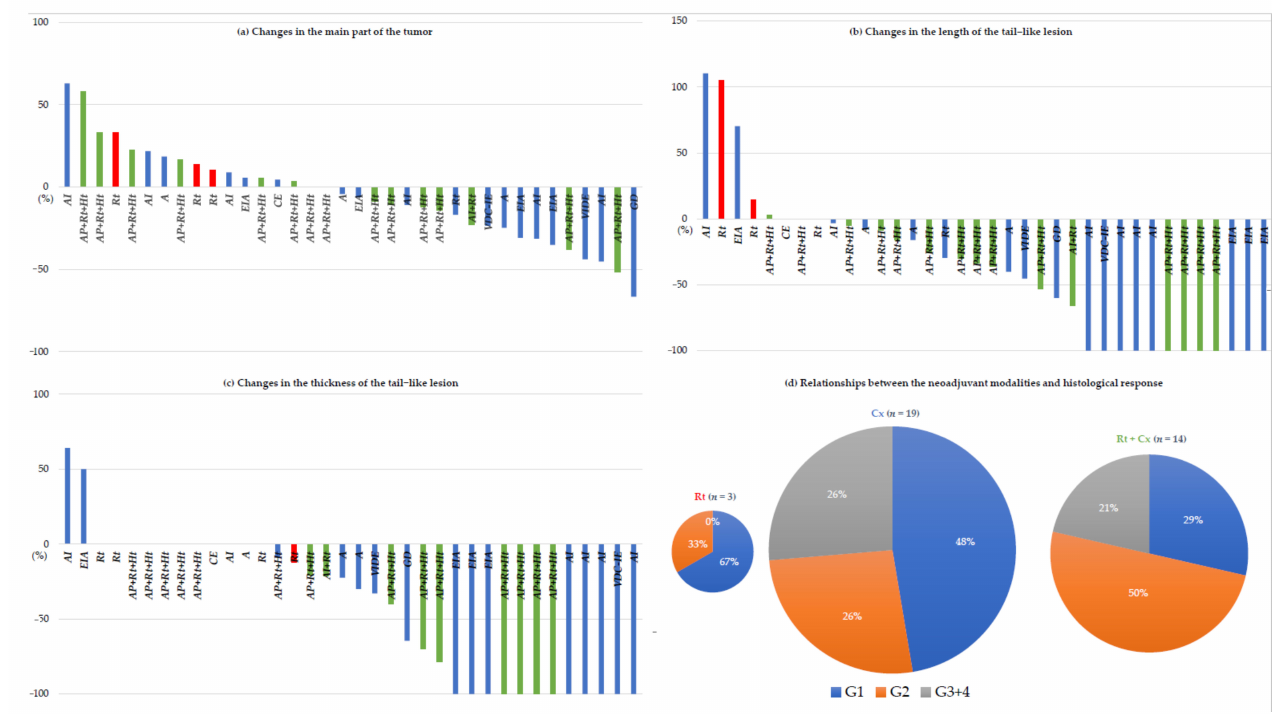
Figure 2. Waterfall plots illustrating the rates of change in the tumor with various neoadjuvant therapies. The rates of change were evaluated using the aforementioned method. ( a ) The rates of change in the main part of the tumor; ( b ) the rates of change in the length of the tail-like lesion; ( c ) the rates of change in the thickness of the tail-like lesion. The red bars indicate radiotherapy, blue bars indicate chemotherapy, and green bars indicate combination therapy (chemoradiotherapy); ( d ) the pie charts indicate the relationships between the neoadjuvant modalities and histological response (4-tier classification). For readability, grades 3 and 4 were integrated. In the Rt + Cx group, hyperthermia was added as an augmentation. A, Adriamycin; C, carboplatin; Cx, chemotherapy; D, docetaxel; E, etoposide; G, gemcitabine; Ht, hyperthermia; I, ifosfamide; P, cisplatin; Rt, radiotherapy; VDC/IE, vincristine + Adriamycin + cyclophosphamide/ifosfamide + etoposide; VIDE, vincristine + ifosfamide + Adriamycin + etoposide.